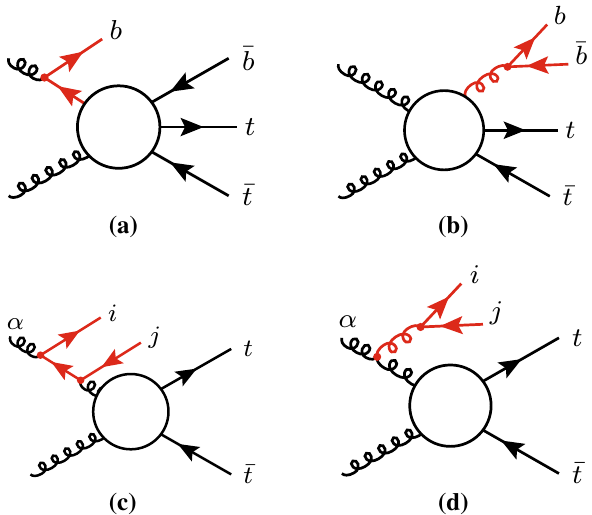
Fig. 5 Generic leading-order gg → t ¯ tb ¯ b topologies. The first line shows the most general form of topologies with IS ( a ) and FS ( b ) g → b ¯ b splittings.Thesecondlineshowsthegenericformofthosetopologies with IS ( c ) and FS ( d ) splittings that turn out to dominate gg → t ¯ tb ¯ b . The labels ij = 56 , 65 stand for the b ¯ b system, while α = 1 , 2 indicates the initial-state gluon that generates the